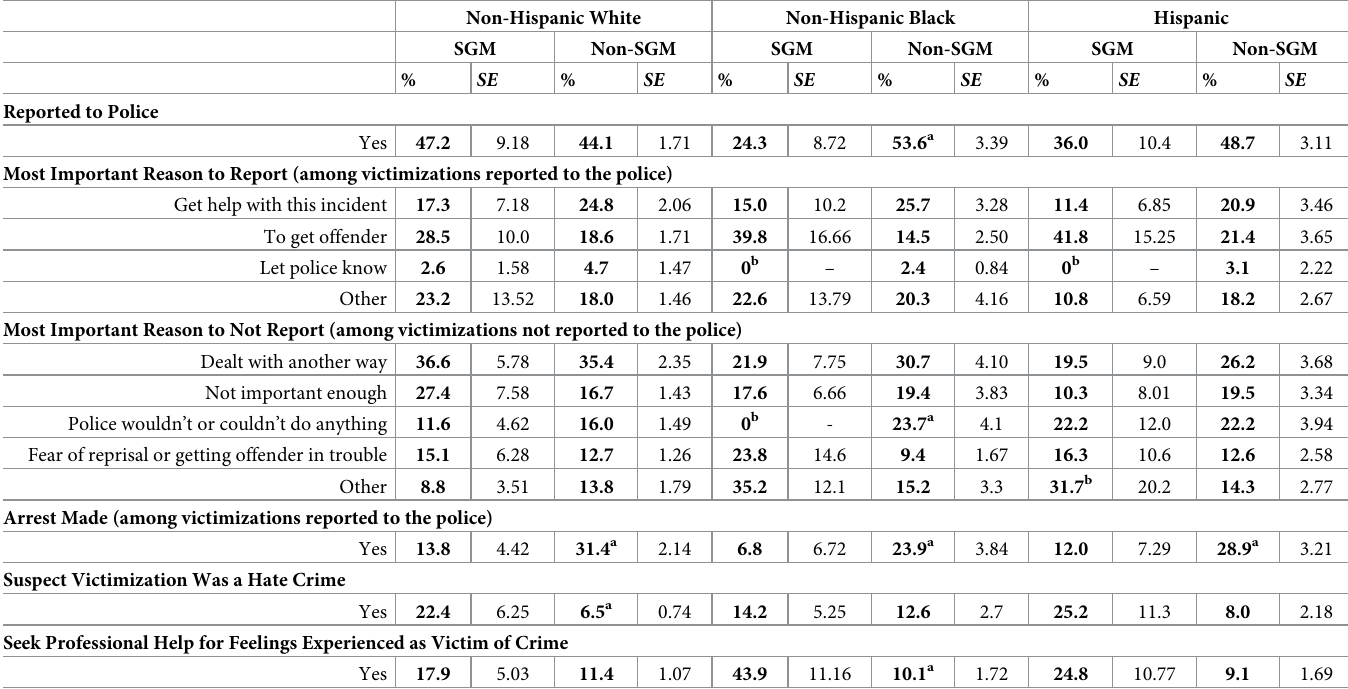
Table 2. Victimization characteristics by SGM status and race or